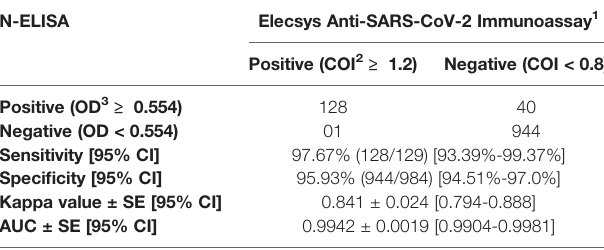
TABLE 2 | N-ELISA performance with regard to the Elecsys Anti-SARS-CoV-2 Immunoassay as gold standard test. N-ELISA Elecsys Anti-SARS-CoV-2 Immunoassay